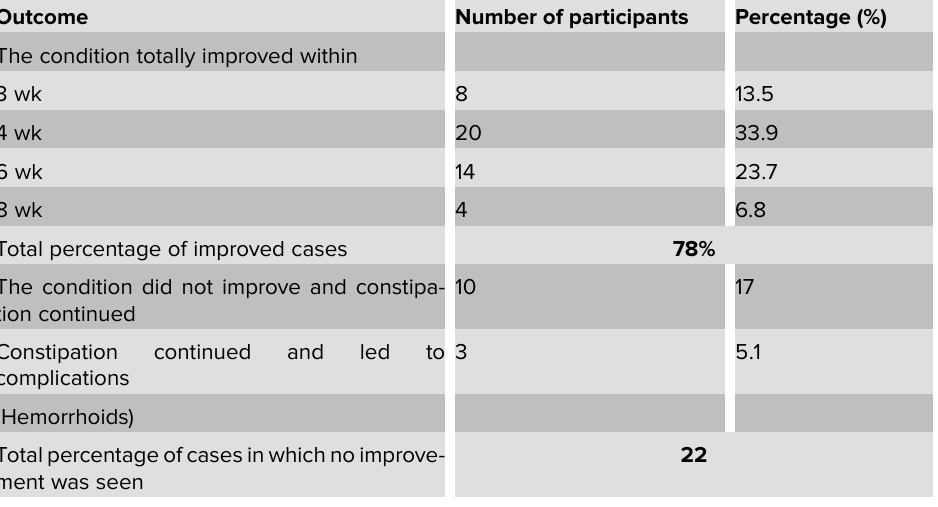
Table 5: Health status of the study population post-intervention (reduction of constipation), n = 59.